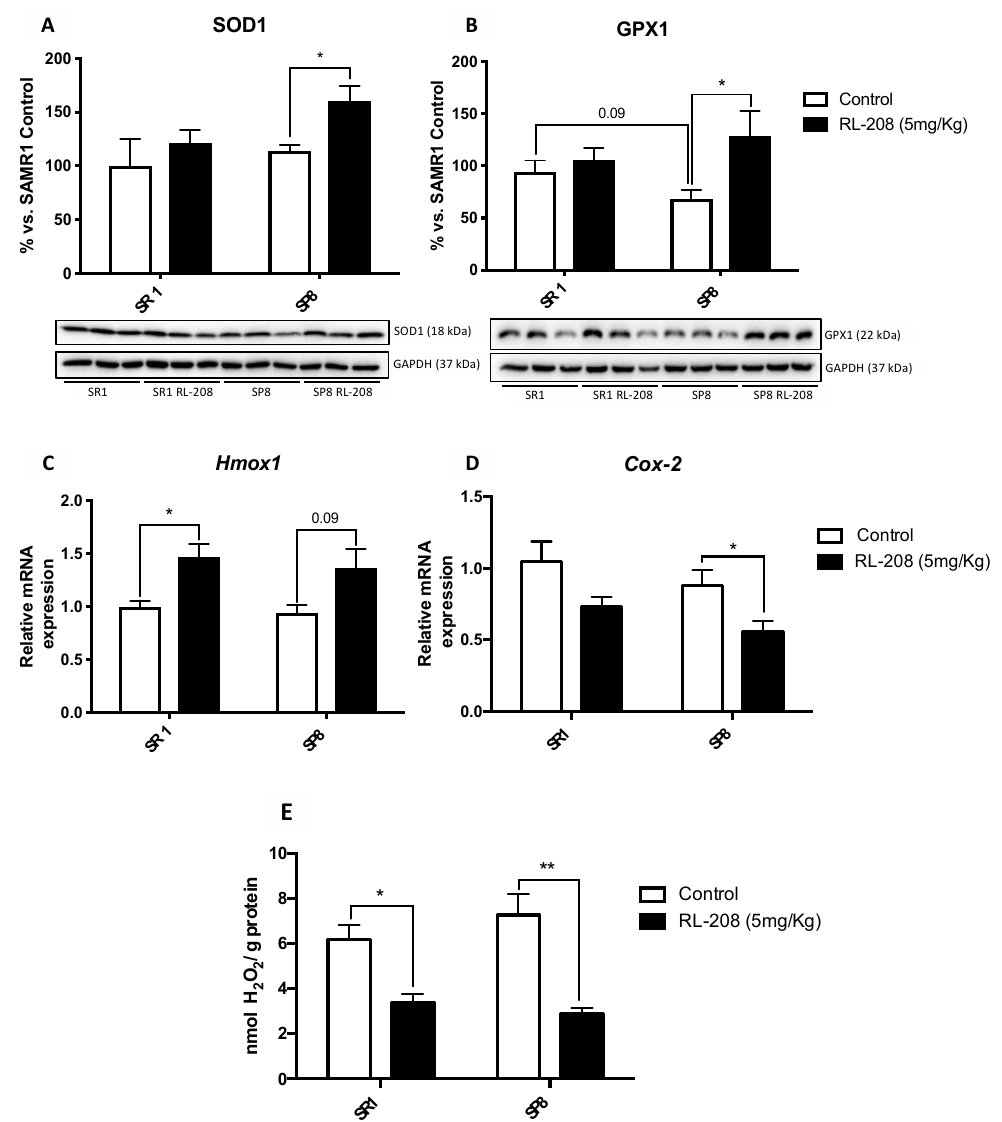
Figure 6. Representative Western Blot and quantifications of antioxidant enzymes for SOD1 ( A ), and GPX1 ( B ). Representative gene expression of the antioxidant enzyme for Hmox1 ( C ), and pro-oxidant enzyme for Cox2 ( D ). Representative OS measured as hydrogen peroxide concentration in homogenates of the hippocampus tissue ( E ). Values in bar graphs are adjusted to 100% for protein levels of the control SAMR1 (SR1 Ct). Gene expression levels were determined by real-time PCR. Values represented are mean ± Standard error of the mean (SEM); (n = 6 for each group). * p < 0.05; ** p < 0.01.